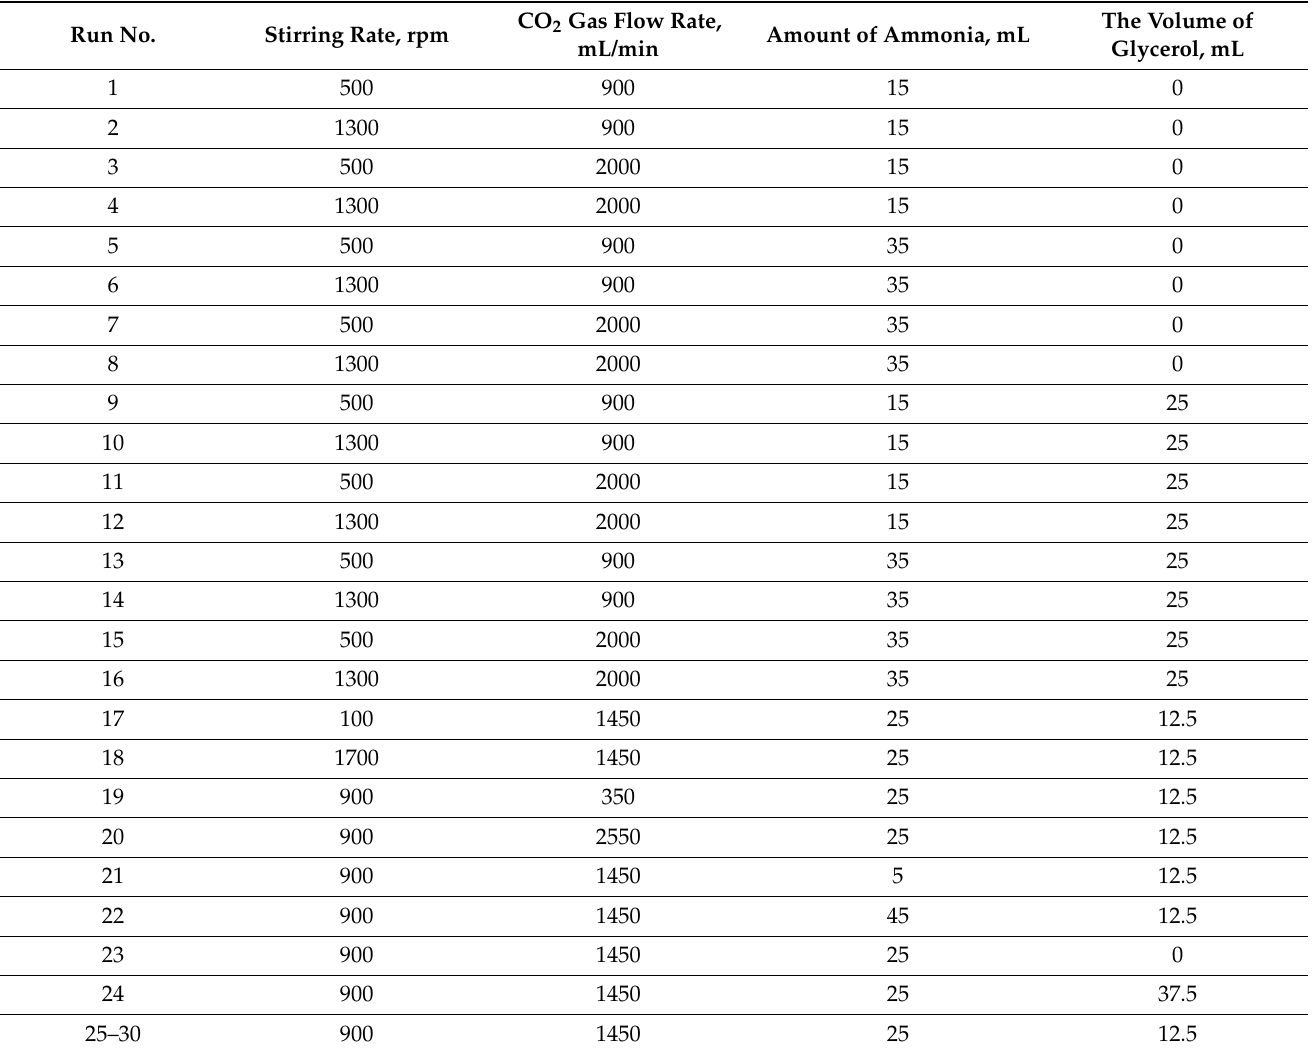
Table 5. CaCO 3 experimental